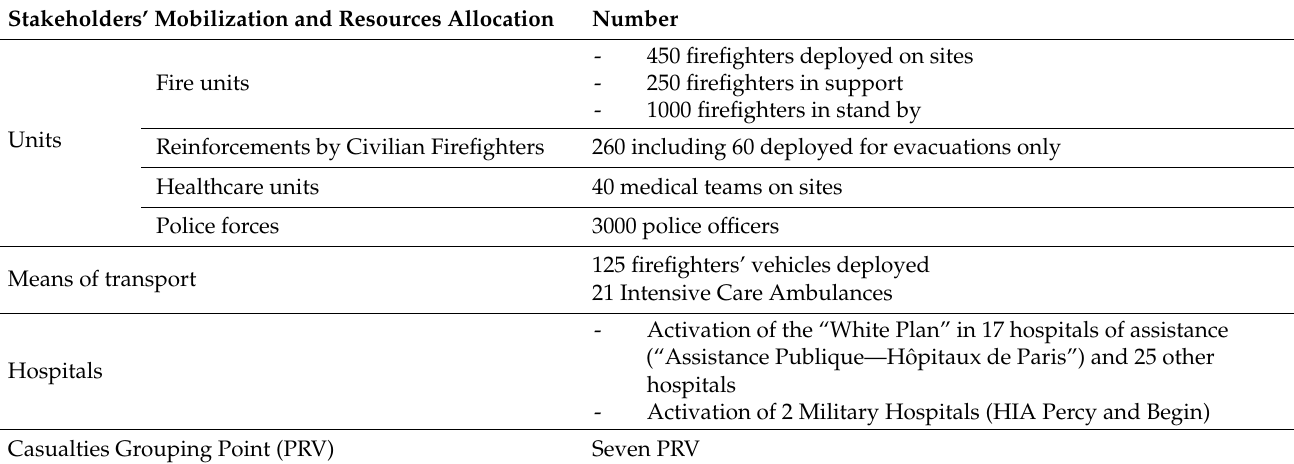
Table 6. Outline of stakeholders’ mobilization and resources allocation on Friday, 13 November